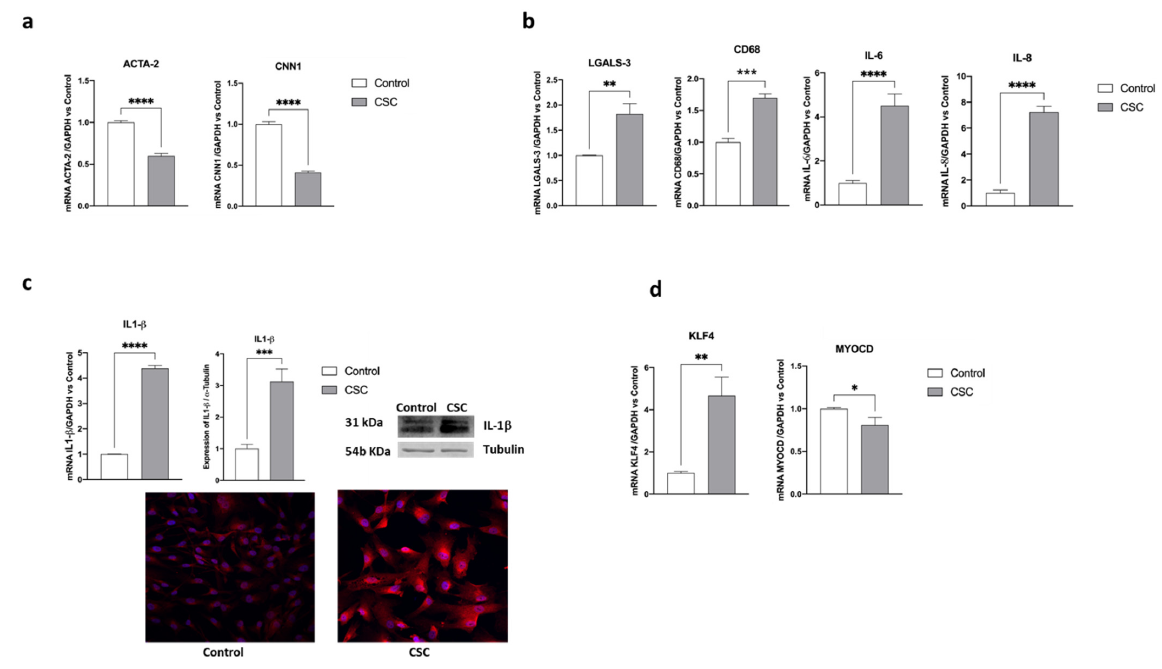
Figure 3. CSC induces HSMC phenotypic switch. Human SMCs were incubated for 48 h with CSC (30 µg/mL). Then, the expression of ( a ) contractile or ( b , c ) in fl ammatory genes was evaluated using RT-PCR. ( c ) IL-1 β protein expression was evaluated using RT-PCR, western blot, and confocal microscopy analysis. Images were captured at 40× magni fi cation using a FRET FLIM confocal microscope. ( d ) The expression of KLF4 and MYOCD genes was measured using RT-PCR. Data are the mean ± SD of at least three experiments performed in triplicates. * p < 0.05, ** p < 0.01; *** p < 0.005; **** p < 0.001 vs.